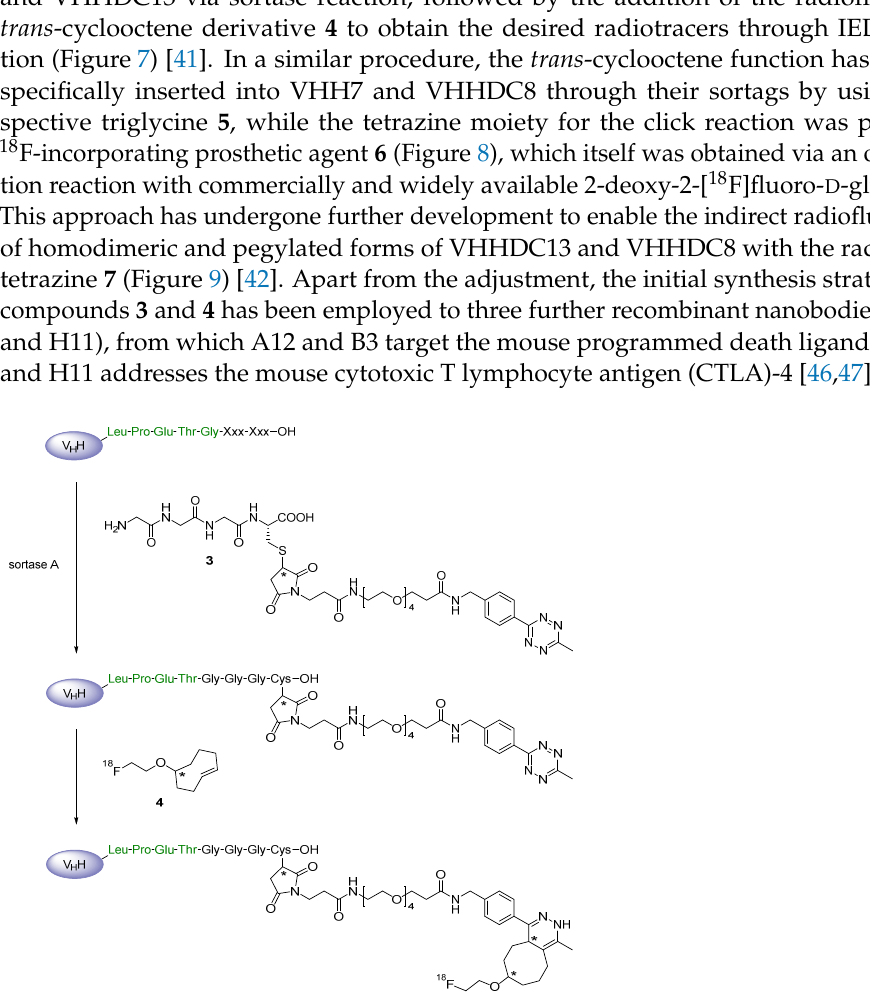
Figure 6. Reaction mechanism of the sortase A-mediated transpeptidation for labeling nanobodies site-specifically at the C -terminus [44]. LPXTG, sortase A-recognition motif; X, any amino acid except cysteine; G, glycine; SH, thiol function of the active site cysteine; C=O, carbonyl carbon of threonine. Such N -terminal oligoglycines decorated with specific functionalities have been used by Rashidian et al. in order to site-specifically modify the three nanobodies so that an inverse-electron demand Diels-Alder (IEDDA) cycloaddition between a tetrazine and a trans -cyclooctene moiety could be employed for the installation of 18 F-containing prosthetic groups [40–42]. Firstly, the linker-connected triglycine-methyltetrazine compound 3 has